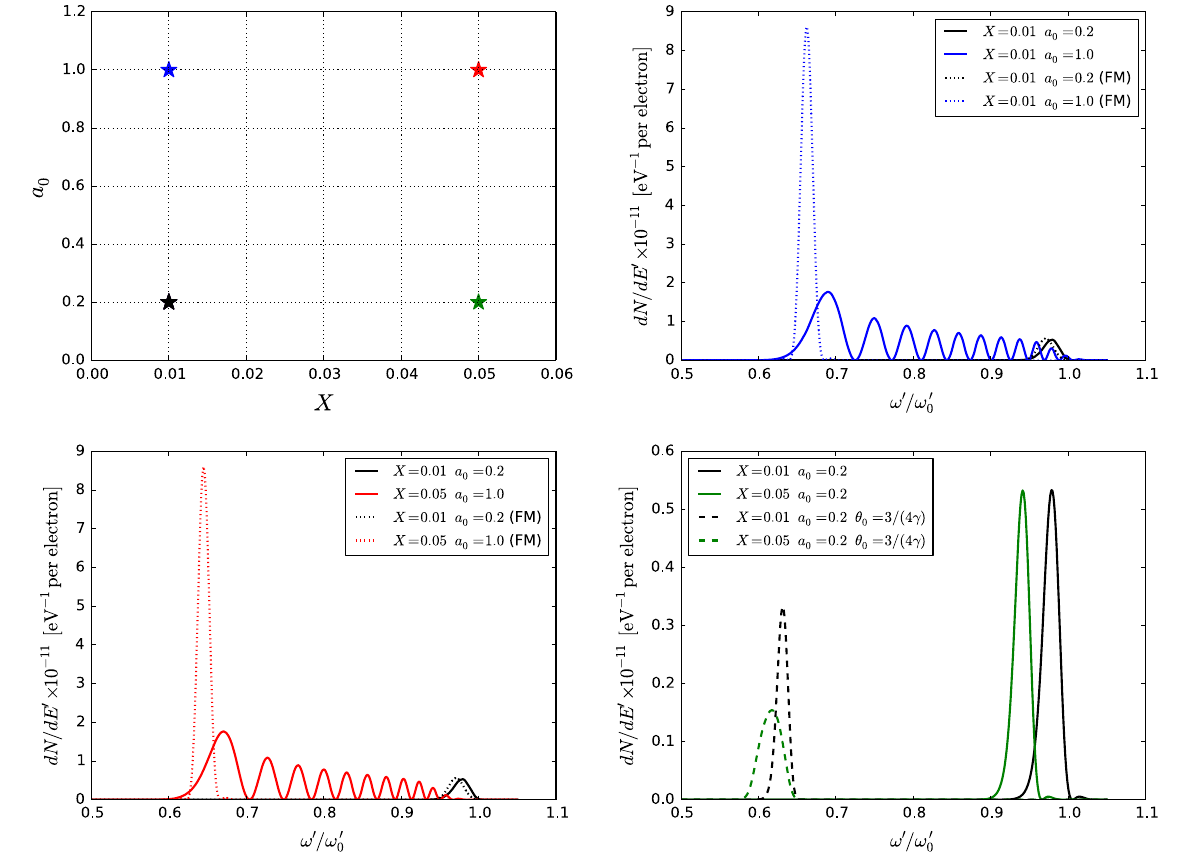
FIG. 3. Interplay between nonlinearities due to the high laser field ( a 0 ≫ 0 ) and due to the electron recoil ( X ≫ 0 ) and their influence on the scattered spectra. Top left: four cases sampling different regimes of the ICS parameter space — linear Thomson (black star); linear Compton (green star); nonlinear Thomson (blue star); and nonlinear Compton (red star). The remaining panels show the comparison between the single on-axis electron backscattered spectra for a linear Thomson case ( X ¼ 0 . 01 , E ¼ 421 MeV, a 0 ¼ 0 . 2 ; black lines) and a nonlinear Thomson case ( X ¼ 0 . 01 , E ¼ 421 MeV, a 0 ¼ 1 ; blue lines) (top right); a nonlinear Compton case ( X ¼ 0 . 05 , E ¼ 2 . 1 GeV, a ¼ 1 ; red lines) (bottom left); a linear Compton case ( X ¼ 0 . 05 , E ¼ 2 . 1 GeV, a ¼ 0 . 2 ; green lines) (bottom right). 0 0 Also shown in the bottom right panel are the spectra at an oblique mean scattering angle of θ 0 ¼ 3 = ð 4 γ Þ in the vertical direction. Dashed lines denote the spectra with FM and solid lines those without. Laser parameters are λ ¼ 800 nm, s ≡ σ z = λ ¼ 11 . 1 . The aperture used is in all of the simulations is 10 μ